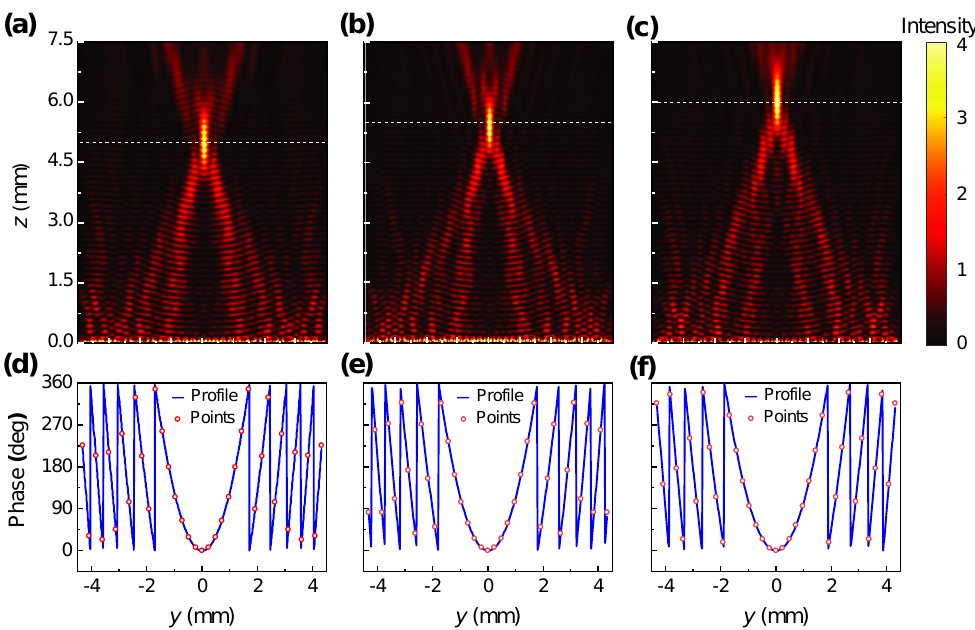
Figure 8. ( a – c ) Electric field intensity distributions | E x | 2 , ( d – f ) desired phase profiles (blue curves) and discrete phase points of the focusing metasurface array with designed focal lengths of ( a , d ) F = 5 mm, ( b , e ) 5.5 mm and ( c , f ) 6 mm operating at 1.05 THz.